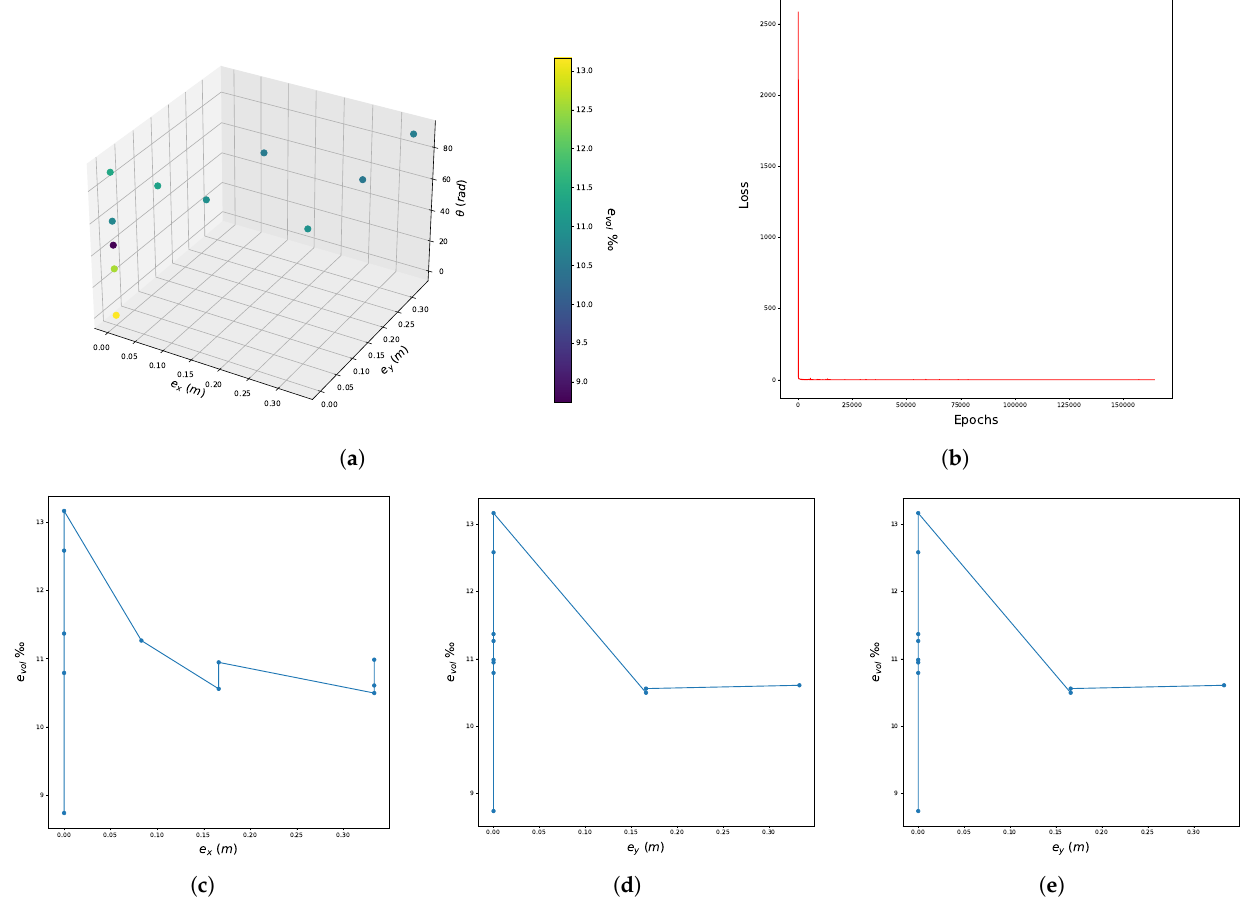
Figure 9. Graphical presentation of the Neural Network that corresponds to Monte Carlo analysis P - κ RF - c RF - k RF − 4 − 10 (NN10) for the estimation of the volumetric component of the strain e vol . ( a ) 3D representation of the Neural Network. ( b ) Epochs-Loss diagram. ( c ) Neural Network representation in the projection of the input axis of e x . ( d ) Neural Network representation in the projection to the input axis of e y . ( e ) Neural Network representation in the projection of the input axis of θ